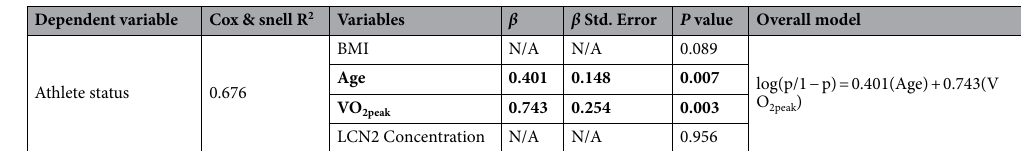
Table 5. Results of sensitivity analysis performed on male athlete status of an individual testing cohort demographic and cardiovascular health characteristics as well as LCN2 concentration. Athletes were assigned as 1 in the dataset, while controls were assigned as 0. The overall model describes the relationship between significant predictors of athlete status and the predicted log odds of the individual tested being an athlete. The model correctly predicted athlete status in 90.5% of individuals in our dataset. BMI, body mass index; SBP, systolic blood pressure; DBP, diastolic blood pressure; LCN2, lipocalin-2; (cardiorespiratory)